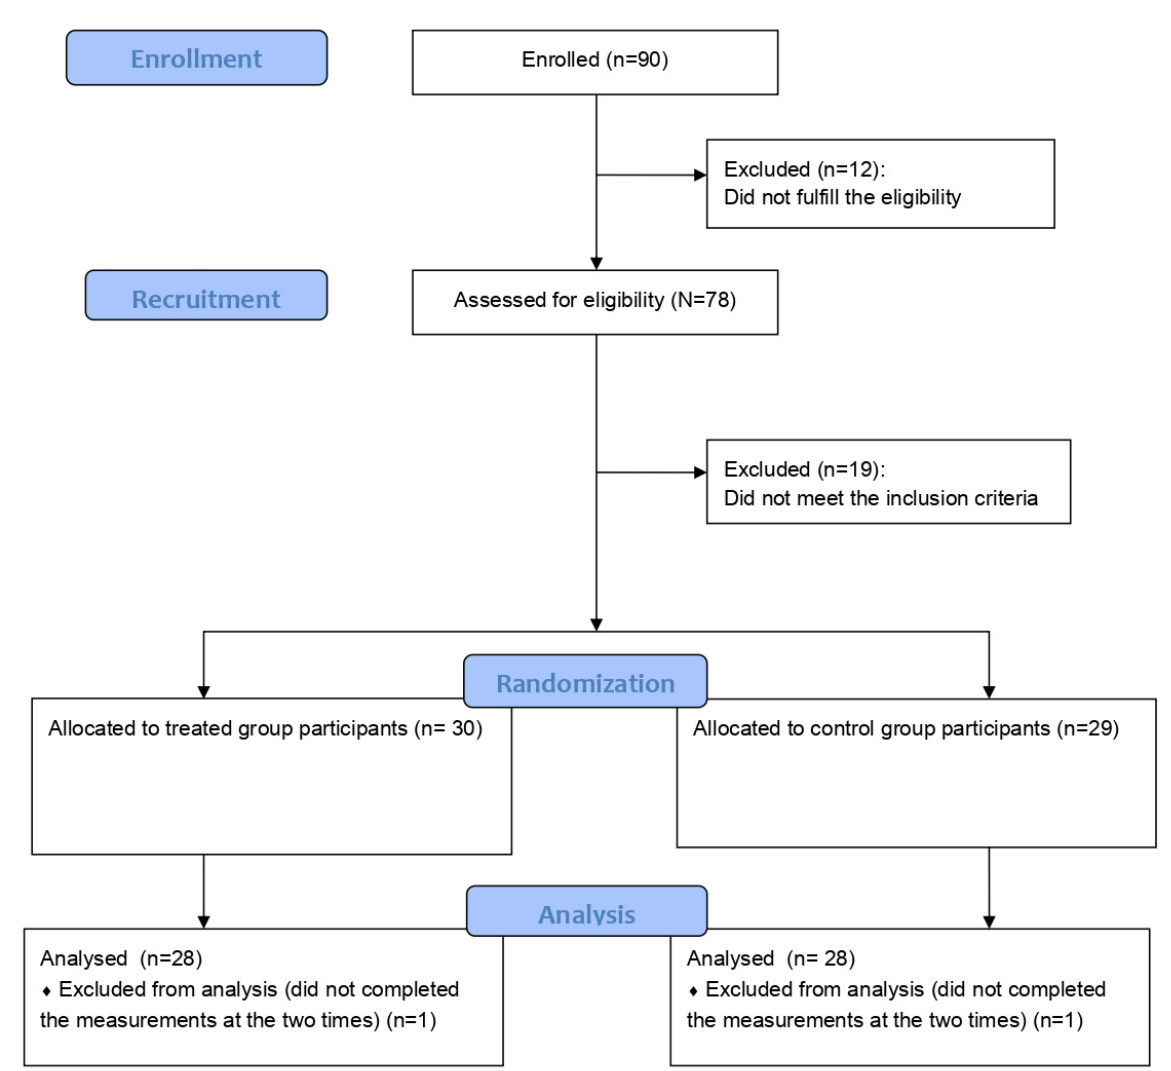
Figure 1. Participant CONSORT flow diagram. Table 2. Mean, SD, internal consistency, and Hedges’ effect size for each questionnaire and subscale in the two groups (controls and treated) at both time points (t o and t 1 ).